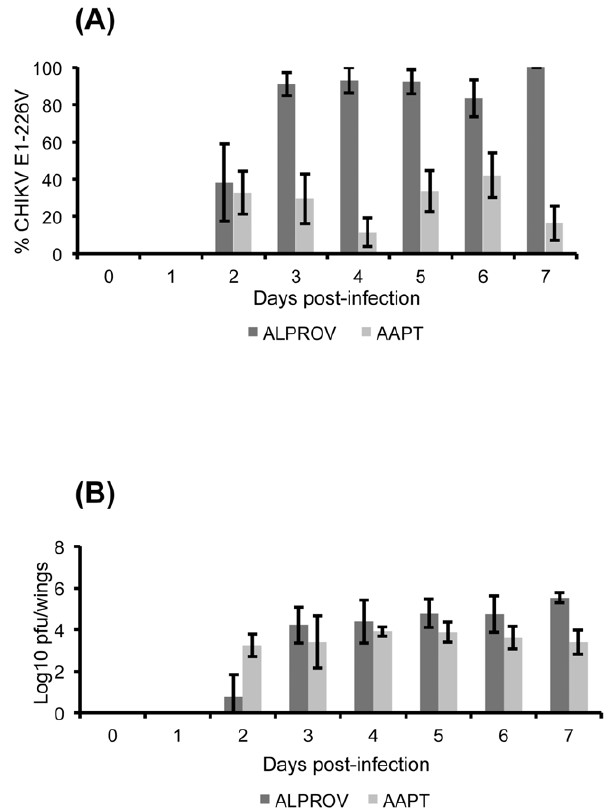
Figure 3. Effect of E1-A226V substitution on CHIKV dissemi- nation to wings of Ae. aegypti (AAPT) and Ae. albopictus (ALPROV). Ae. aegypti (light-grey) and Ae. albopictus (dark-grey) were orally infected with a blood-meal containing both E1-226A and E1-226V provided at the same titer, 10 6.5 pfu/mL. Every day, 5 mosquitoes were sacrificed to isolate the wings. The proportion of E1-226V compared to E1-226A (A) and the number of infectious particles (B) were determined. Error bars show the confidence intervals (95%) for % CHIKV E1-226V and the standard deviations for Log10 pfu/midgut.